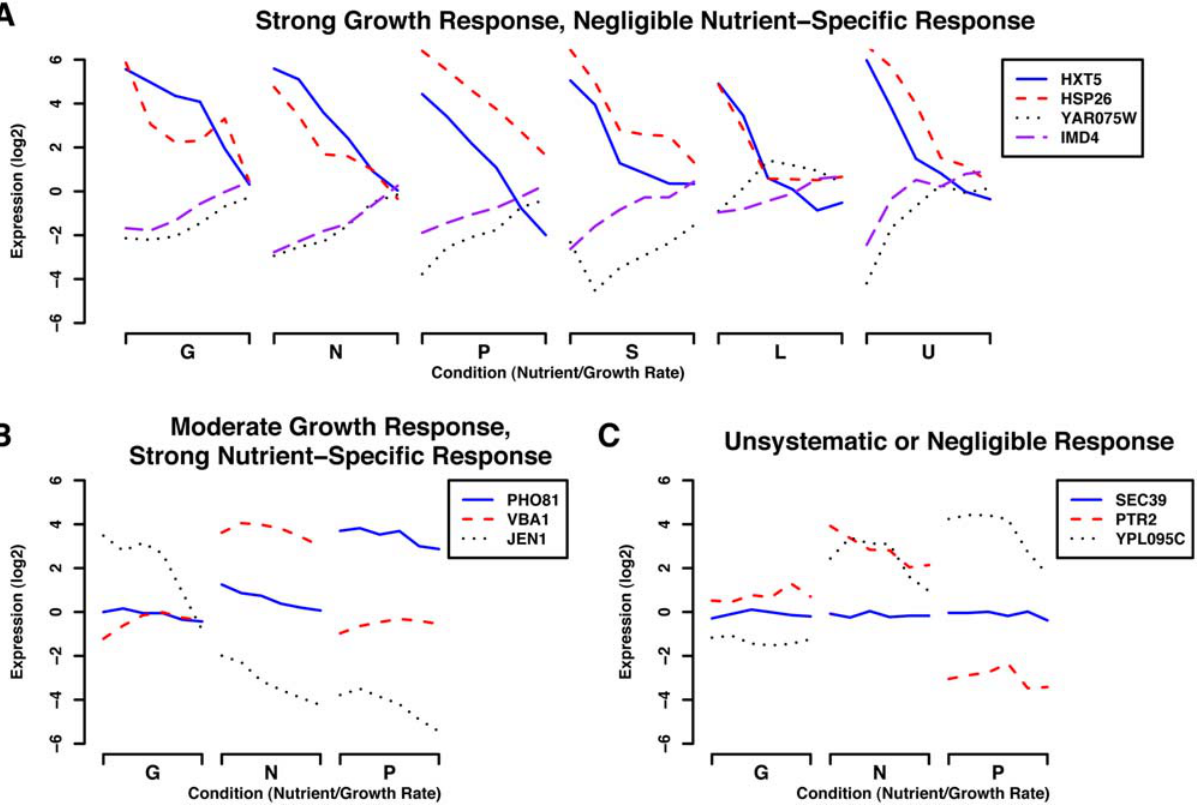
Figure 3. Representative genes responding to growth rate, specific nutrients, or unsystematically in our chemostat-derived training data. Our statistical model of growth rate regulation is based on expression data collected from 36 chemostats at six growth rates (0.05 hr 2 1 through 0.3 hr 2 1 ) under six nutrient limitations (Glucose, Nitrogen, Phosphate, Sulfur, Leucine, and Uracil) as described in [4]. By employing the genes responding strongly, consistently, and only to changes in growth rate (and not specific nutrients) as growth-specific genes, we can apply our model to predict relative growth rates in new expression data. Gene expression in our original 36 conditions fell into three main categories as shown here. (A) Genes strongly up- or down-regulated in response to changes in growth rate, independent of limiting nutrient. The most statistically significant members of this set became our growth-specific calibration genes for application of the linear model to other expression data. (B) A subset of conditions highlighting genes with expression levels showing some correlation with growth rate, but with a strong nutrient- specific component. This represents a sizeable portion of the genome ( , 25%), with positively growth-correlated genes enriched mainly for ribosomal function and negatively correlated genes enriched for oxidative metabolism. (C) A subset of conditions highlighting genes showing a non-systematic or negligible change in gene expression. Unresponsive genes were enriched for a variety of cellular processes not expected to show a strong relationship with growth, e.g. transcription, DNA metabolism and packaging, secretion, and many